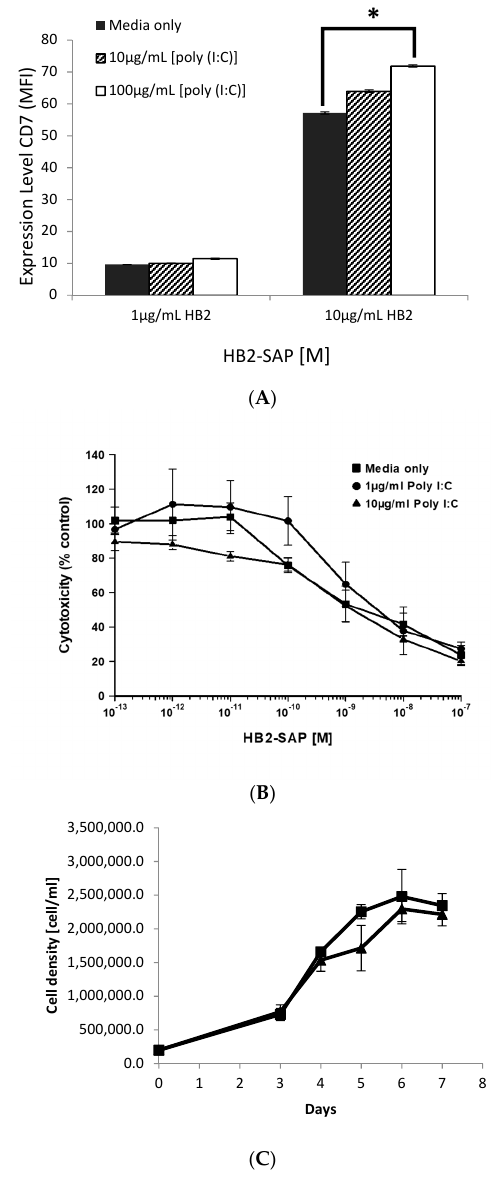
Figure 5. The in vitro effects of [poly (I:C)] on HSB-2 cells. ( A ) Expression levels of CD7 determined by single colour flow cytometry with HB2-SAPORIN IT at 1 or 10 μ g/mL following 24 h exposure to medium only (controls) or [poly (I:C)] at 10 or 100 μ g/mL for 24 h. * p < 0.01 as determined by two sample T-test. ( B ) Cytotoxicity of HB2-SAP IT measured by XTT assay for control HSB-2 cells ( ■ ) or cells exposed to 1 ( ● ) or 10 μ g/mL ( ▲ ) [poly (I:C)] for 24 h prior to assay ( C ) Outgrowth of HSB-2 control cells ( ■ ) or cells continuously exposed to 100 mg/mL [poly (I:C)] ( ▲ ) over a six day period.